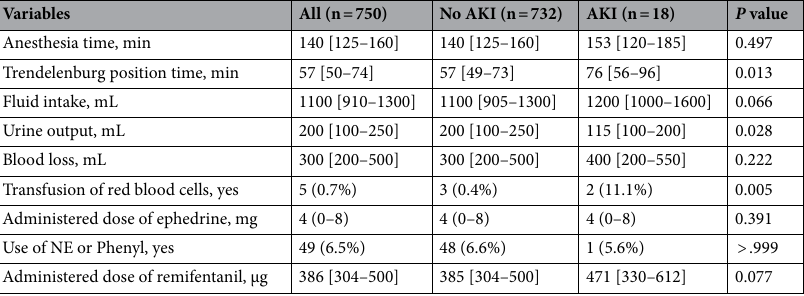
Table 2. Intraoperative characteristics. Values are median (interquartile rage) or number of patients (percentage). AKI acute kidney injury, NE norepinephrine, Phenyl phenylephrine.